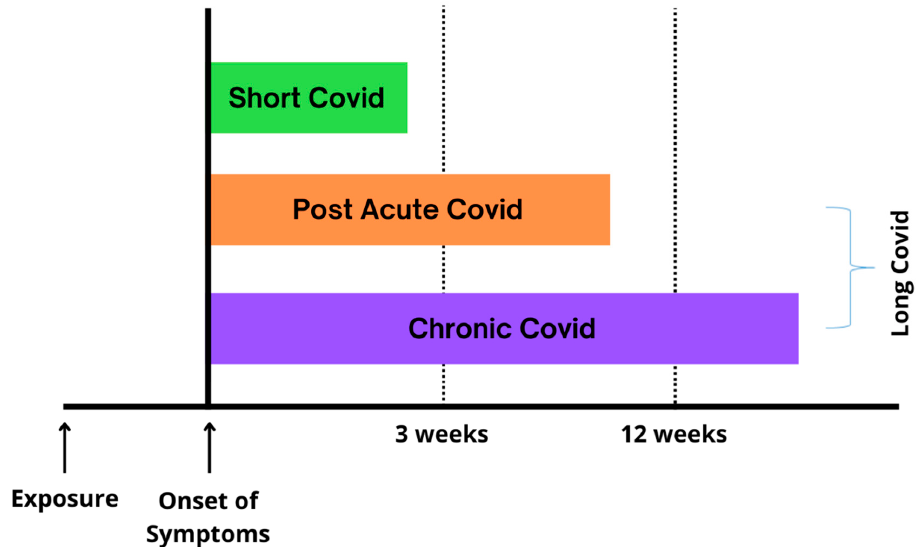
Figure 2. Classification of long COVID.